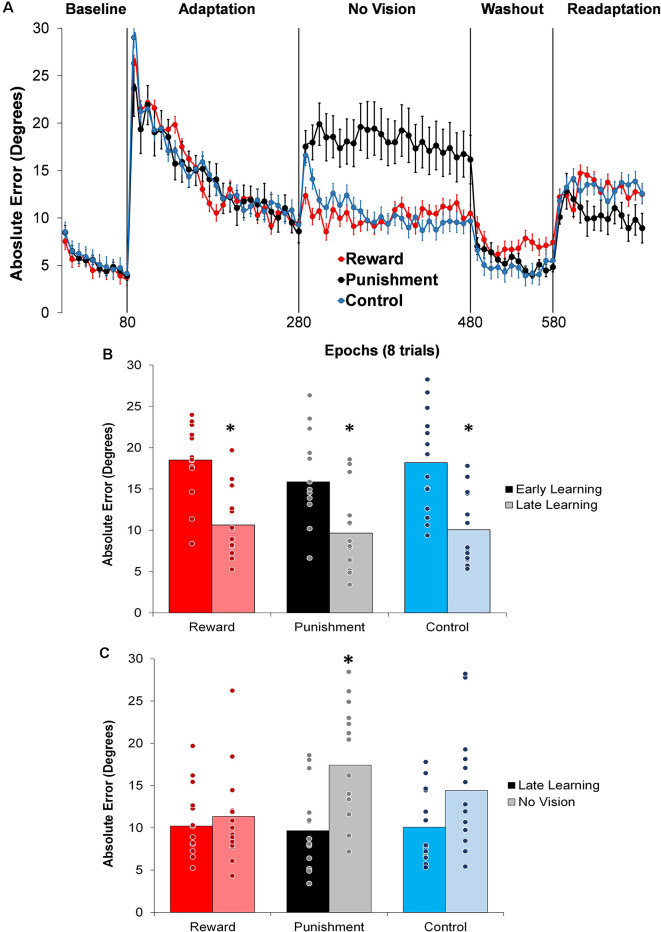
(A) Average absolute performance error across epochs of eight trials in each task condition for each of the groups. Represented as mean ± standard error. (B) Average absolute performance error for all groups during the Adaptation (Early and Late Learning) condition. *p < 0.05 compared to Early Learning. (C) Average absolute performance error for all groups during the Adaptation (Late Learning) and No Vision conditions. *p < 0.05 compared to Late Learning. Bars represent mean and dots represent the individual responses.